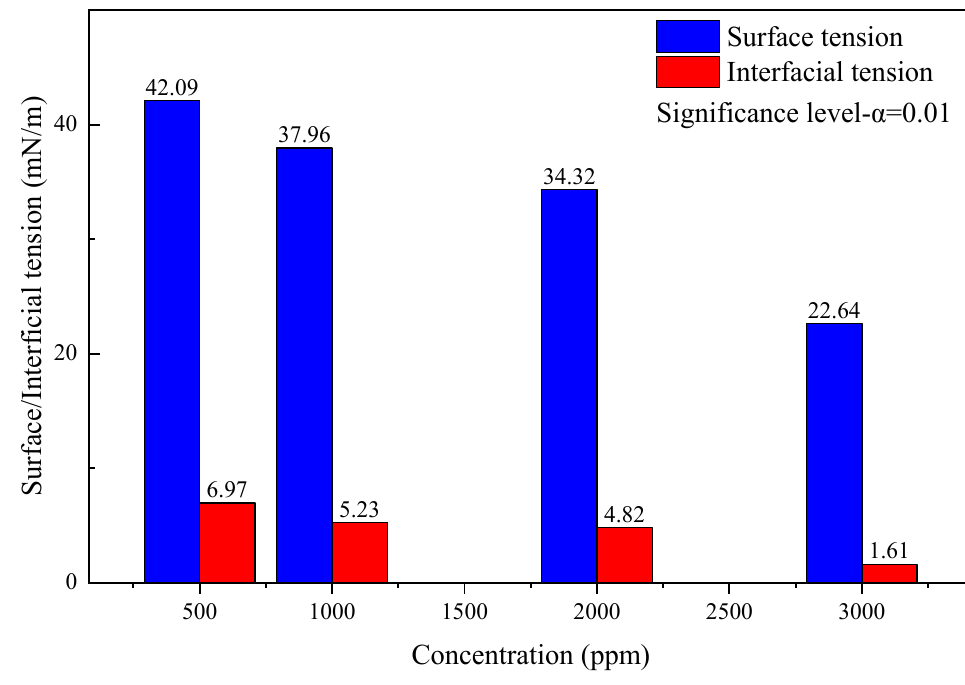
Figure 9. Surface tension and interfacial tension of discharge aiding